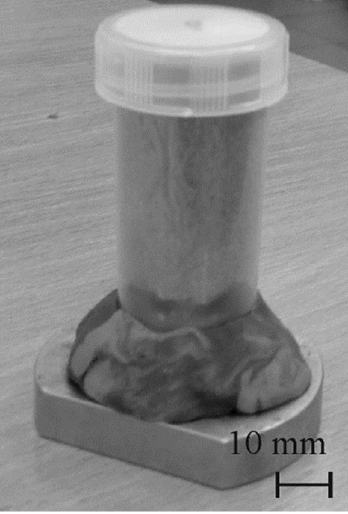
Figure 1. A medium sand sample prepared for testing in microtomography. Table 1. Basic physical properties and classification characteristics of medium sand (MSa—SP) from southern